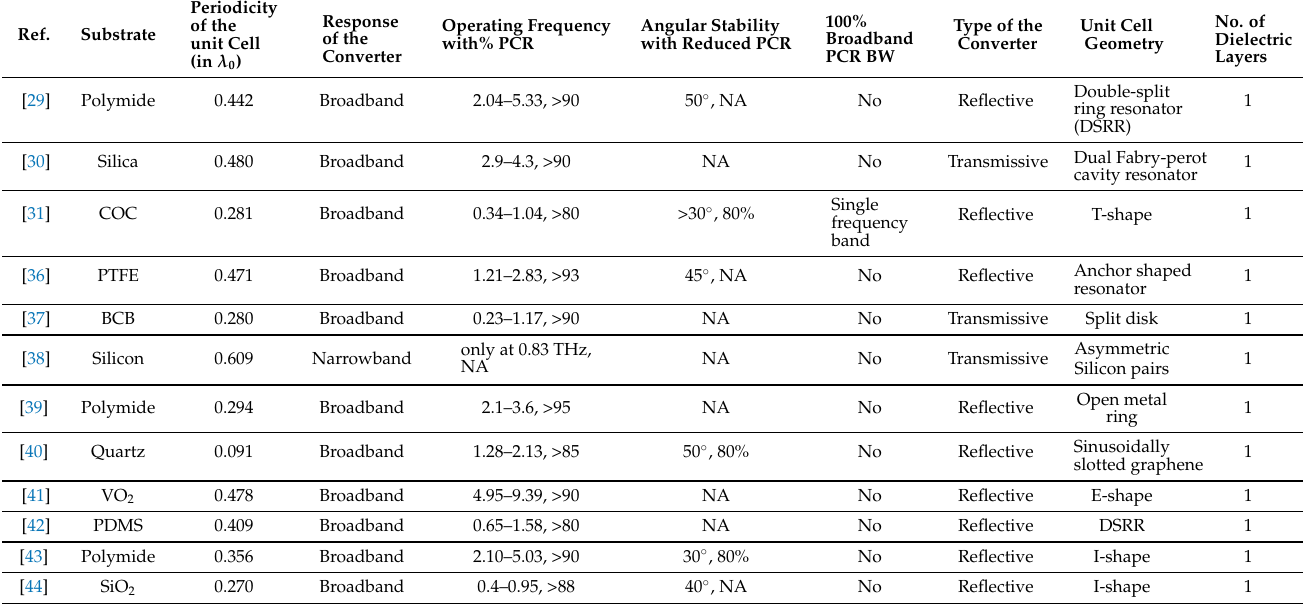
Table 5. State-of-the-art performance comparison table of the proposed converter with previously reported